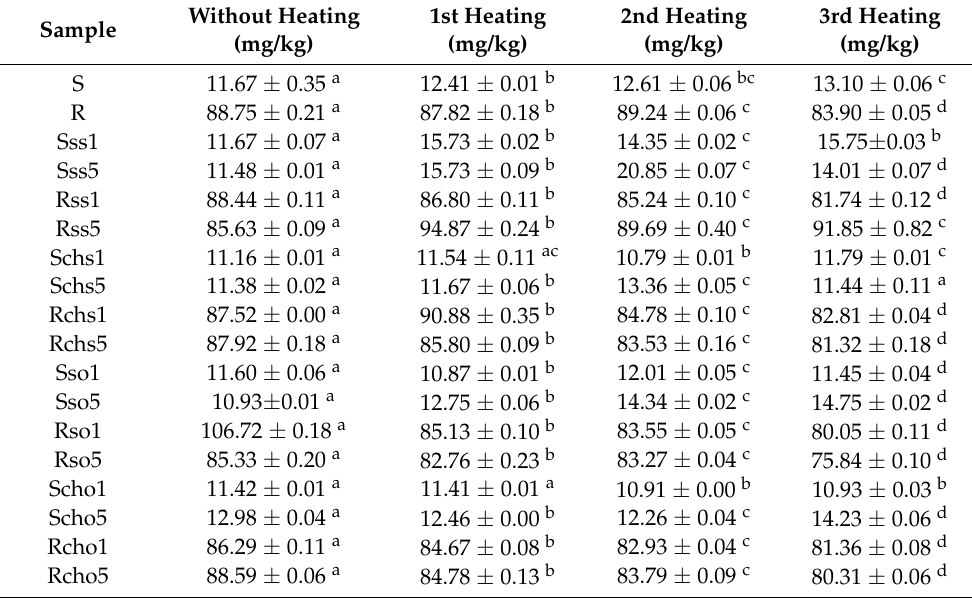
Table 8. Carotenoid content in oil samples after repeated cycles of heating.